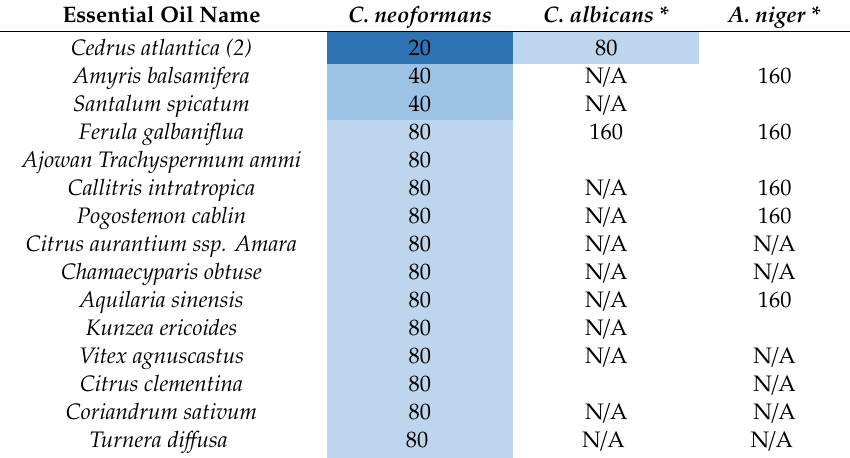
Table 2. Essential Oil Efficacy against Pathogenic Fungi. The more stringent significance cutoff of 100 ppm applies to C. neoformans ; the asterisk (*) indicates a more relaxed susceptibility cutoff of 160 ppm for C. albicans and A. niger . N/A indicates no activity beyond the vehicle carrier control.